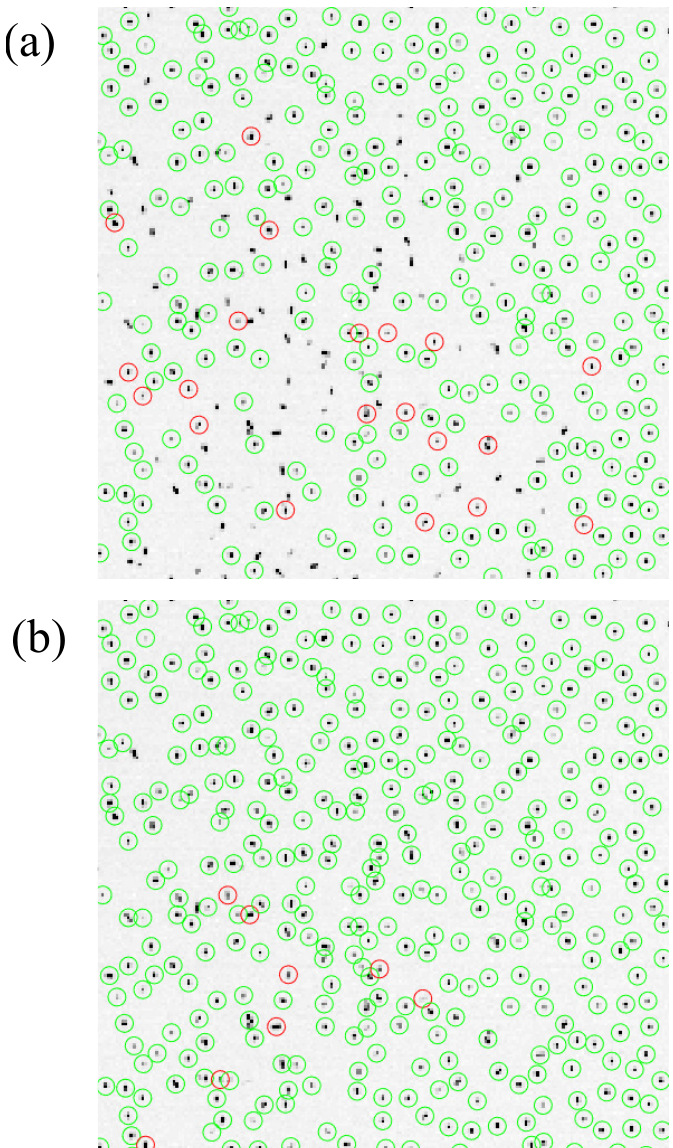
Figure 4. Particles detected and tracked for more than 3 frames at t = 8 s. The green circles correspond to the particles successfully linked to particles detected in the previous frame. The red circles correspond to new (rediscovered) particles and tracked in a minimum of 2 frames afterward. ( a ) Using R i as starting point for locating the particles (quasi-static approximation). ( b ) Using R i point for locating the particles (position prediction). The tracking results are plotted over the original frame. Note that the grey scale of the original image has been changed from 0–255 to 0–64 for better visibility (pixels artificially saturate if their intensity is greater than